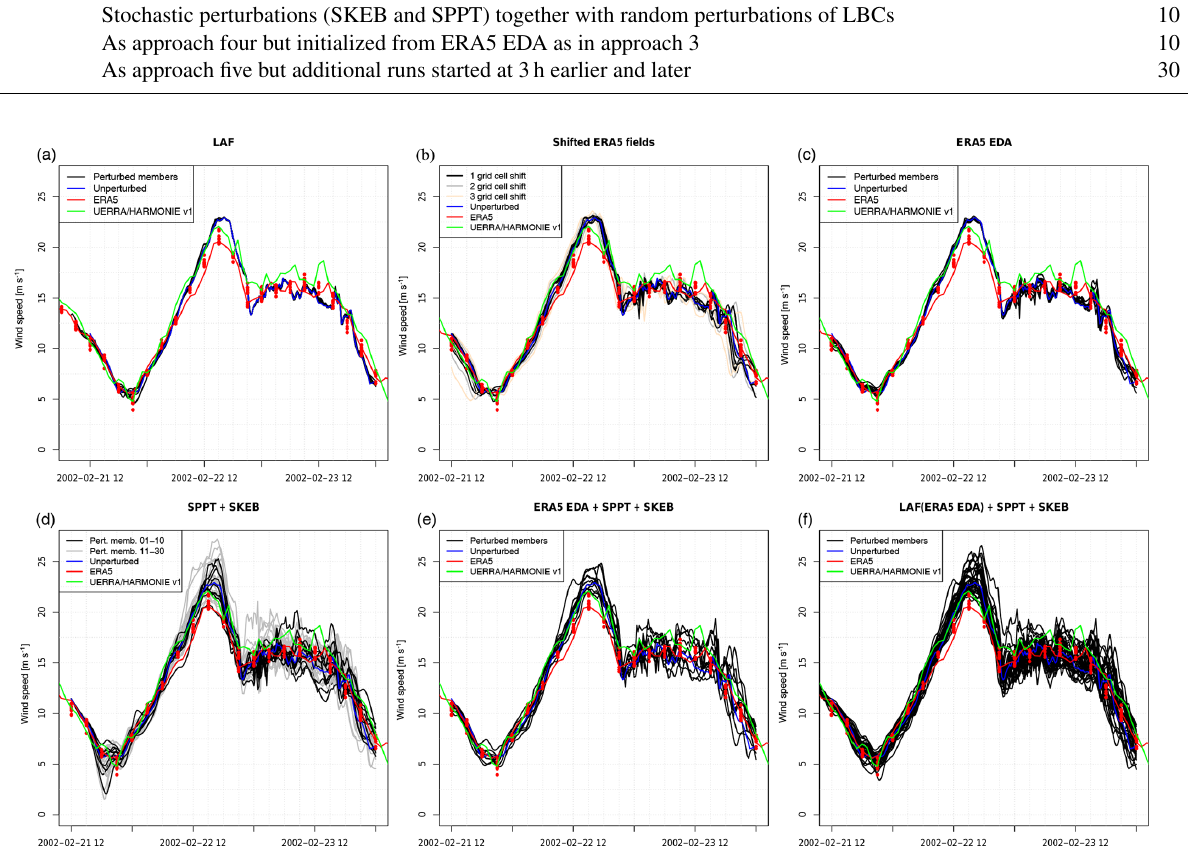
Figure 2. Time series demonstrating the simulation results of the different ensemble generation strategies at one specific location: (a) lagged- average forecast (LAF) ensemble (Hoffman and Kalnay, 1983), (b) domain shifting (Pardowitz et al., 2016), (c) WRF runs started from 10 ERA5 4D-EnVAR members with HRES LBCs, (d) stochastic perturbations (SPPT and SKEB) (Buizza et al., 1999; Shutts, 2005), (e) ERA5 4D-EnVAR as starting conditions plus stochastic perturbations, and (d) LAF started from ERA5 4D-EnVAR at 09:00, 12:00 and 15:00UTC plus stochastic perturbations; results shown for 56.17 ◦ N, 19.39 ◦